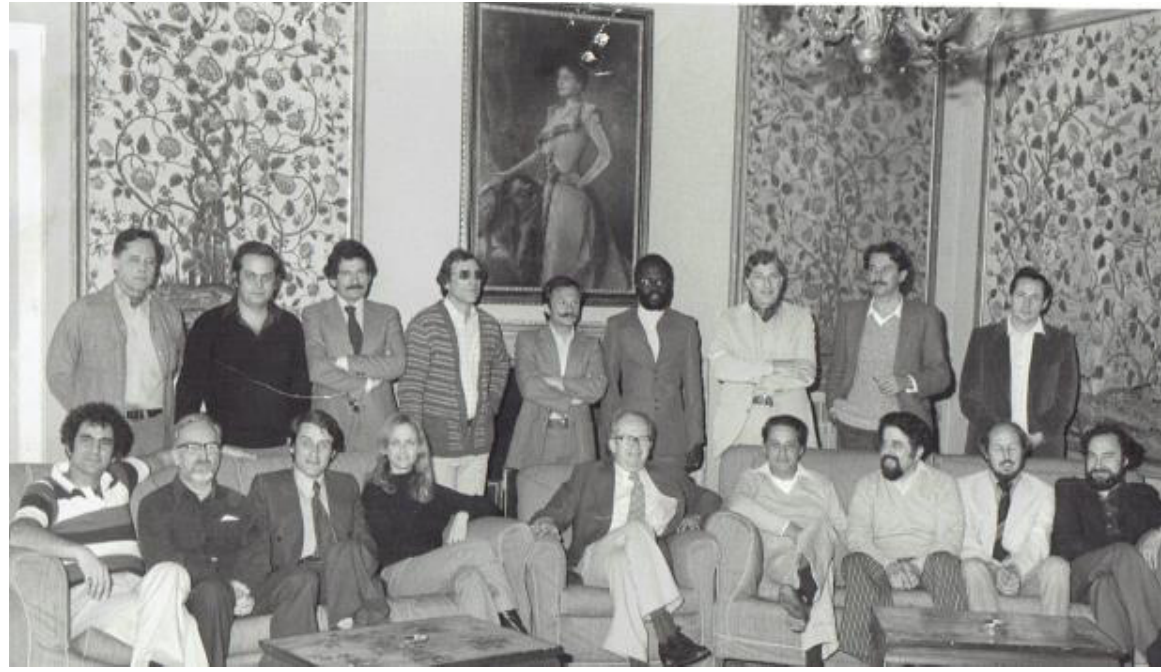
Figure 2. Bellagio RC02 Conference,